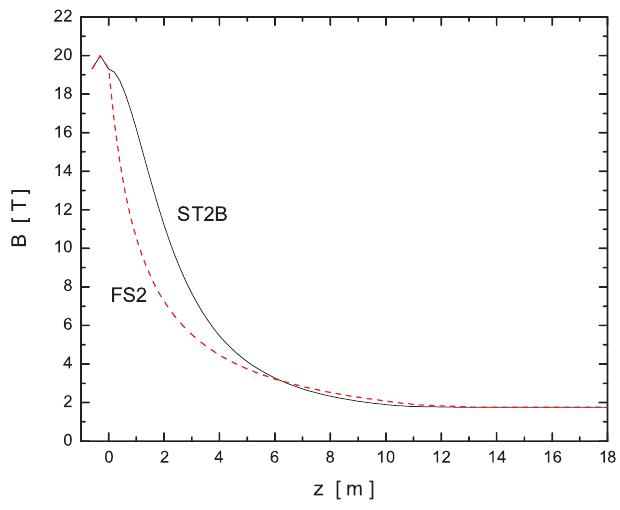
target.FIG. 6. (Color) Comparison of the capture region magnetic field used in the present simulation (ST2B) with that used in FS2.